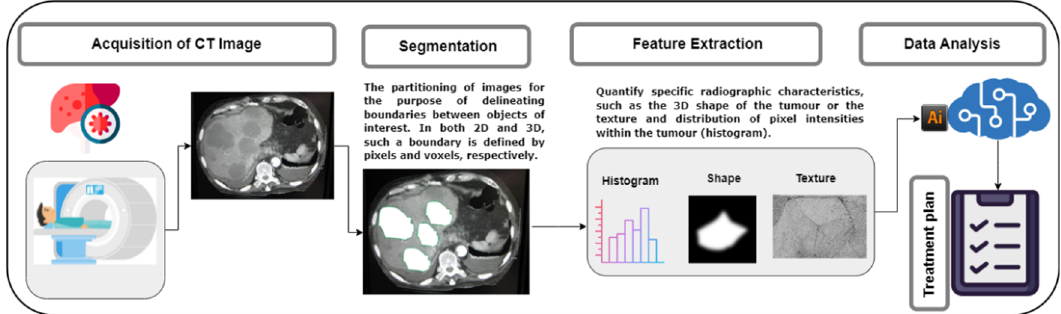
Figure 2. Radiomics